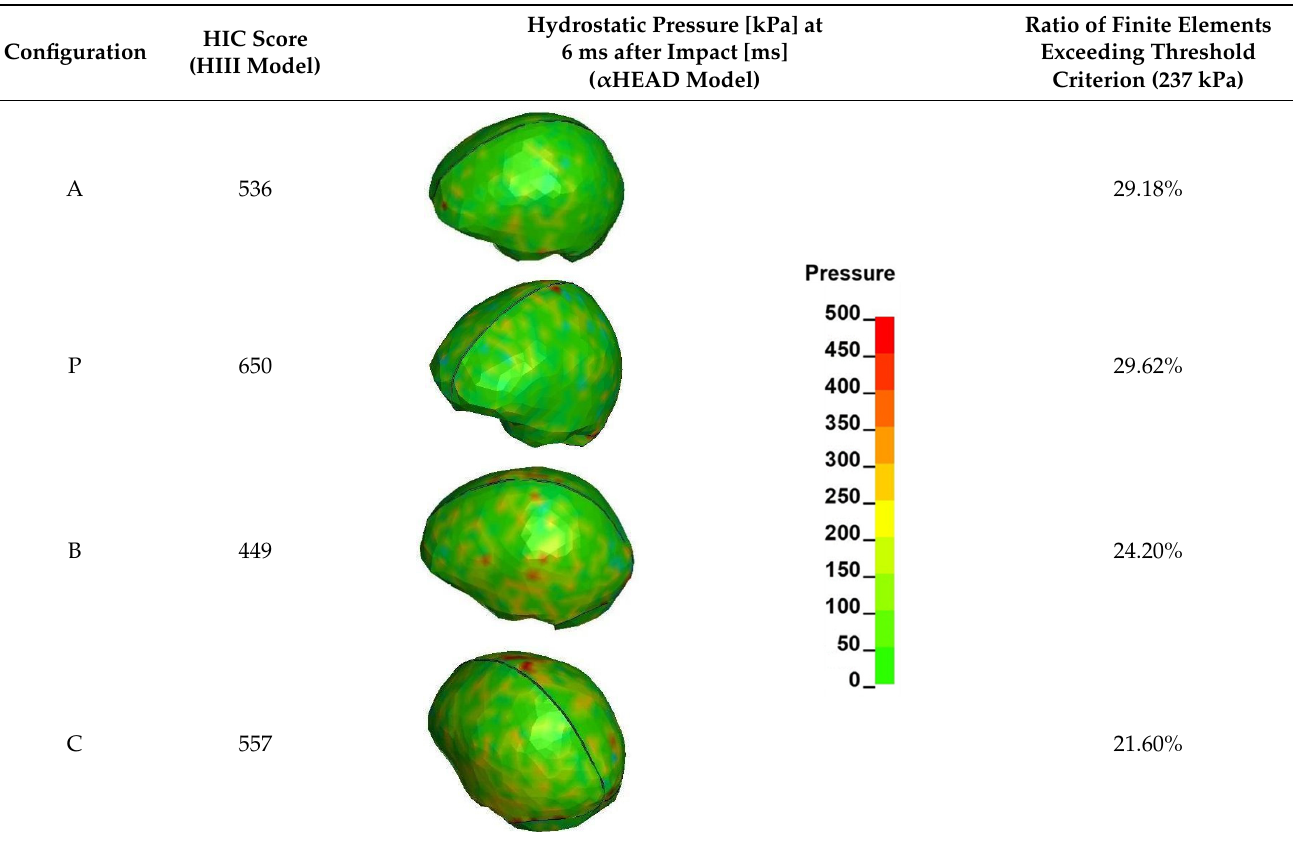
Table 5. Comparison of the HIC score for the Hybrid III dummy to the maximal value of hydrostatic pressure for α HEAD.